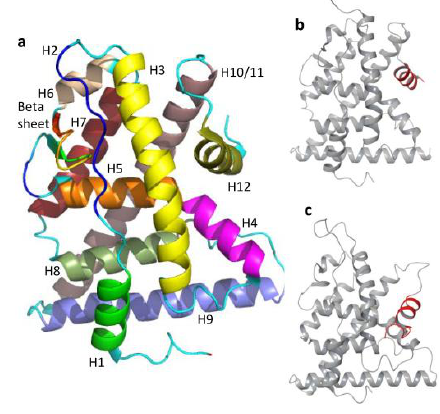
Figure 4. General architecture of an ER LBD comprising twelve α-helices and a beta sheet/hairpin. The twelve α-helices (H1 to H12) that form the ―three-layered anti-parallel α (PDB ID: 1GWR) ( b ). The conformation of an inactive ER (PDB ID: 3ERT) ( c ). The major difference between b and c lies in the H12 conformation, highlighted in